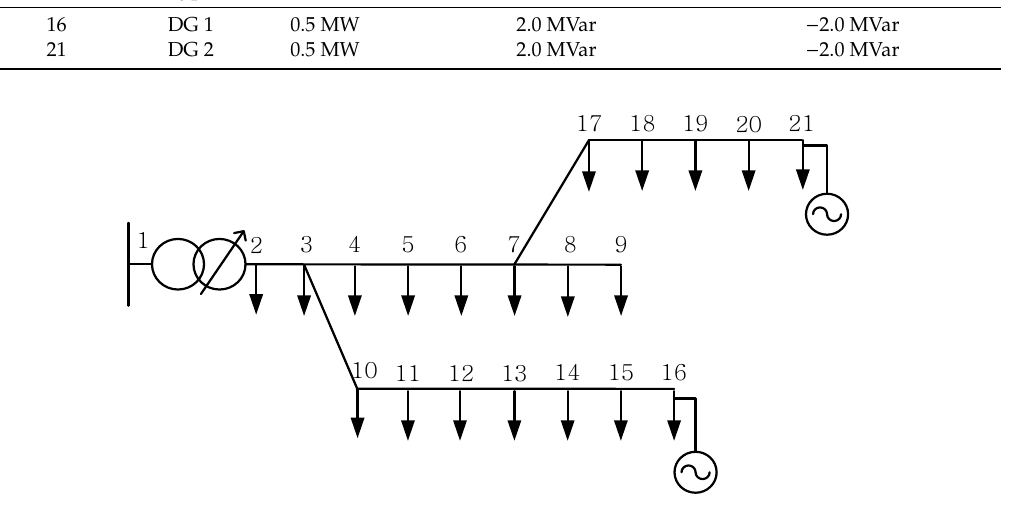
Figure 20. Single diagram of distribution network of case 2.